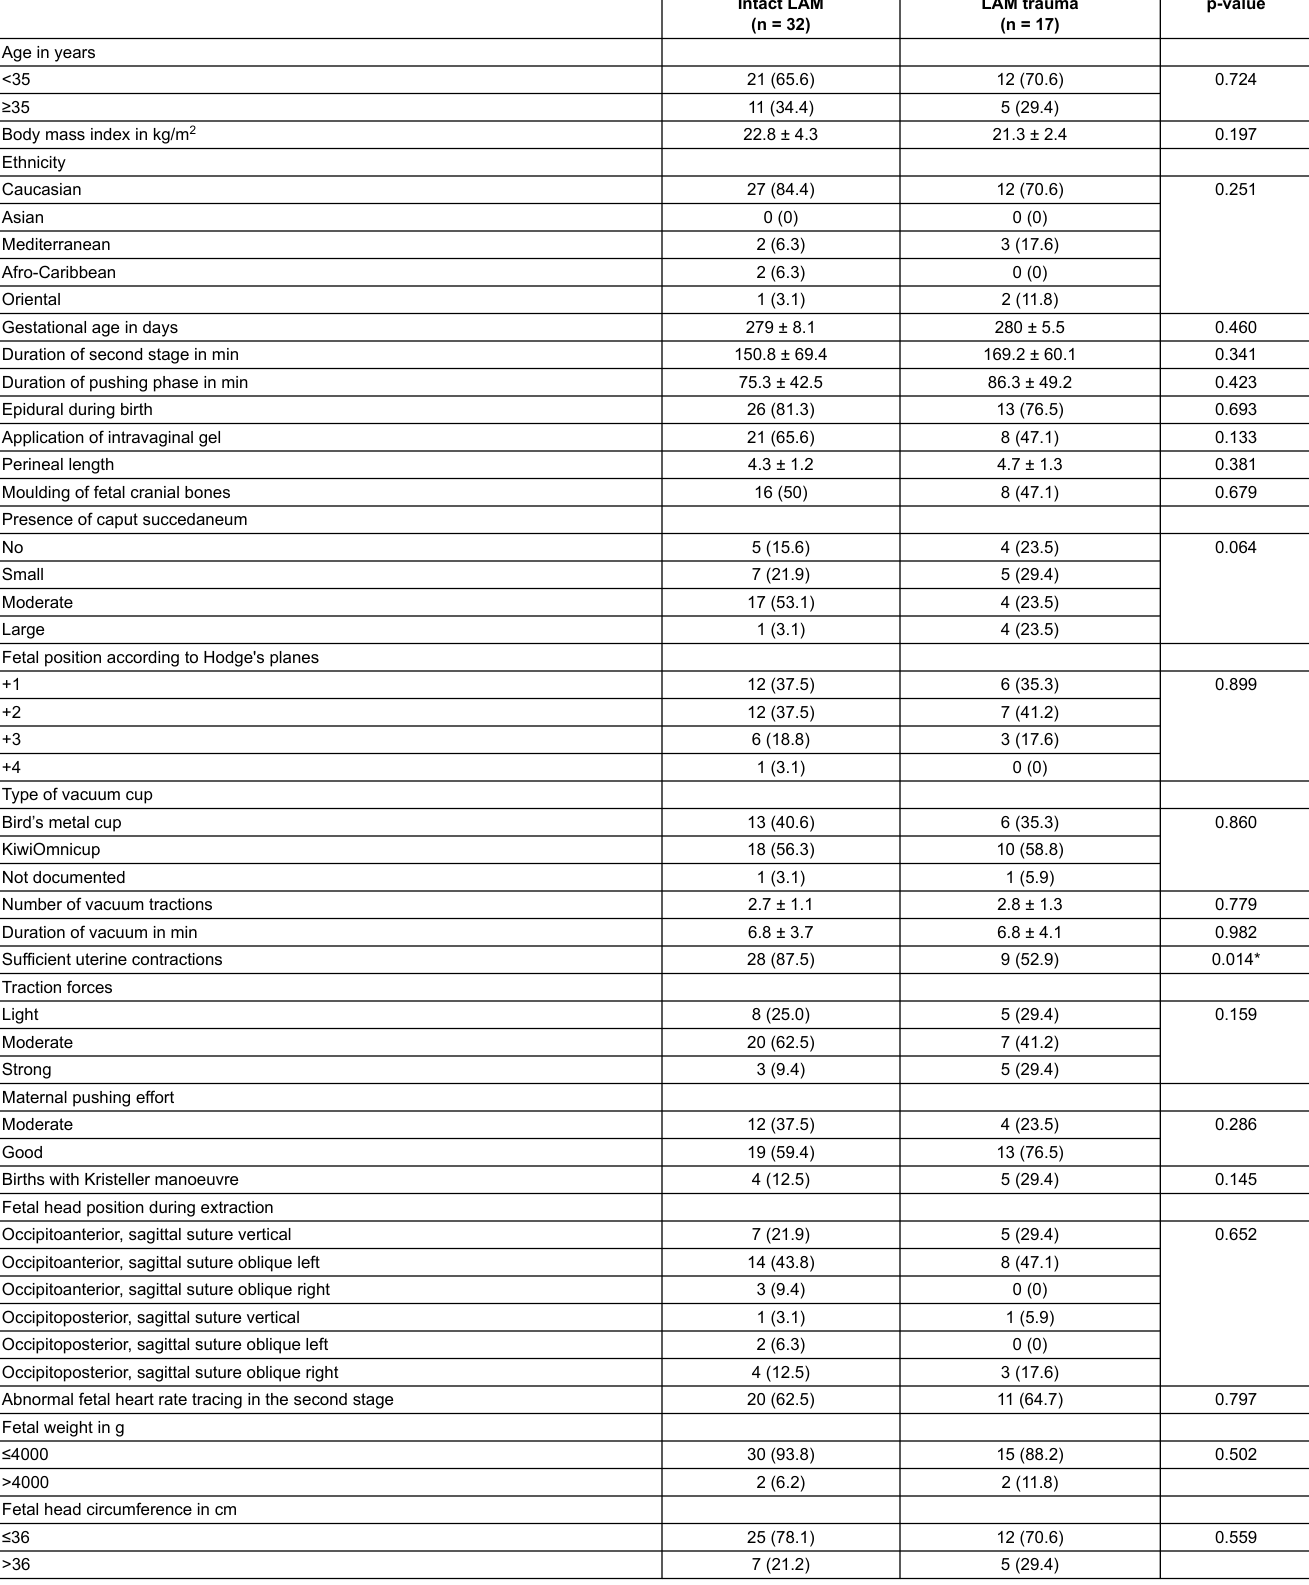
Table 1: Characteristics of the 49 women after vacuum-assisted birth with or without levator ani muscle (LAM)